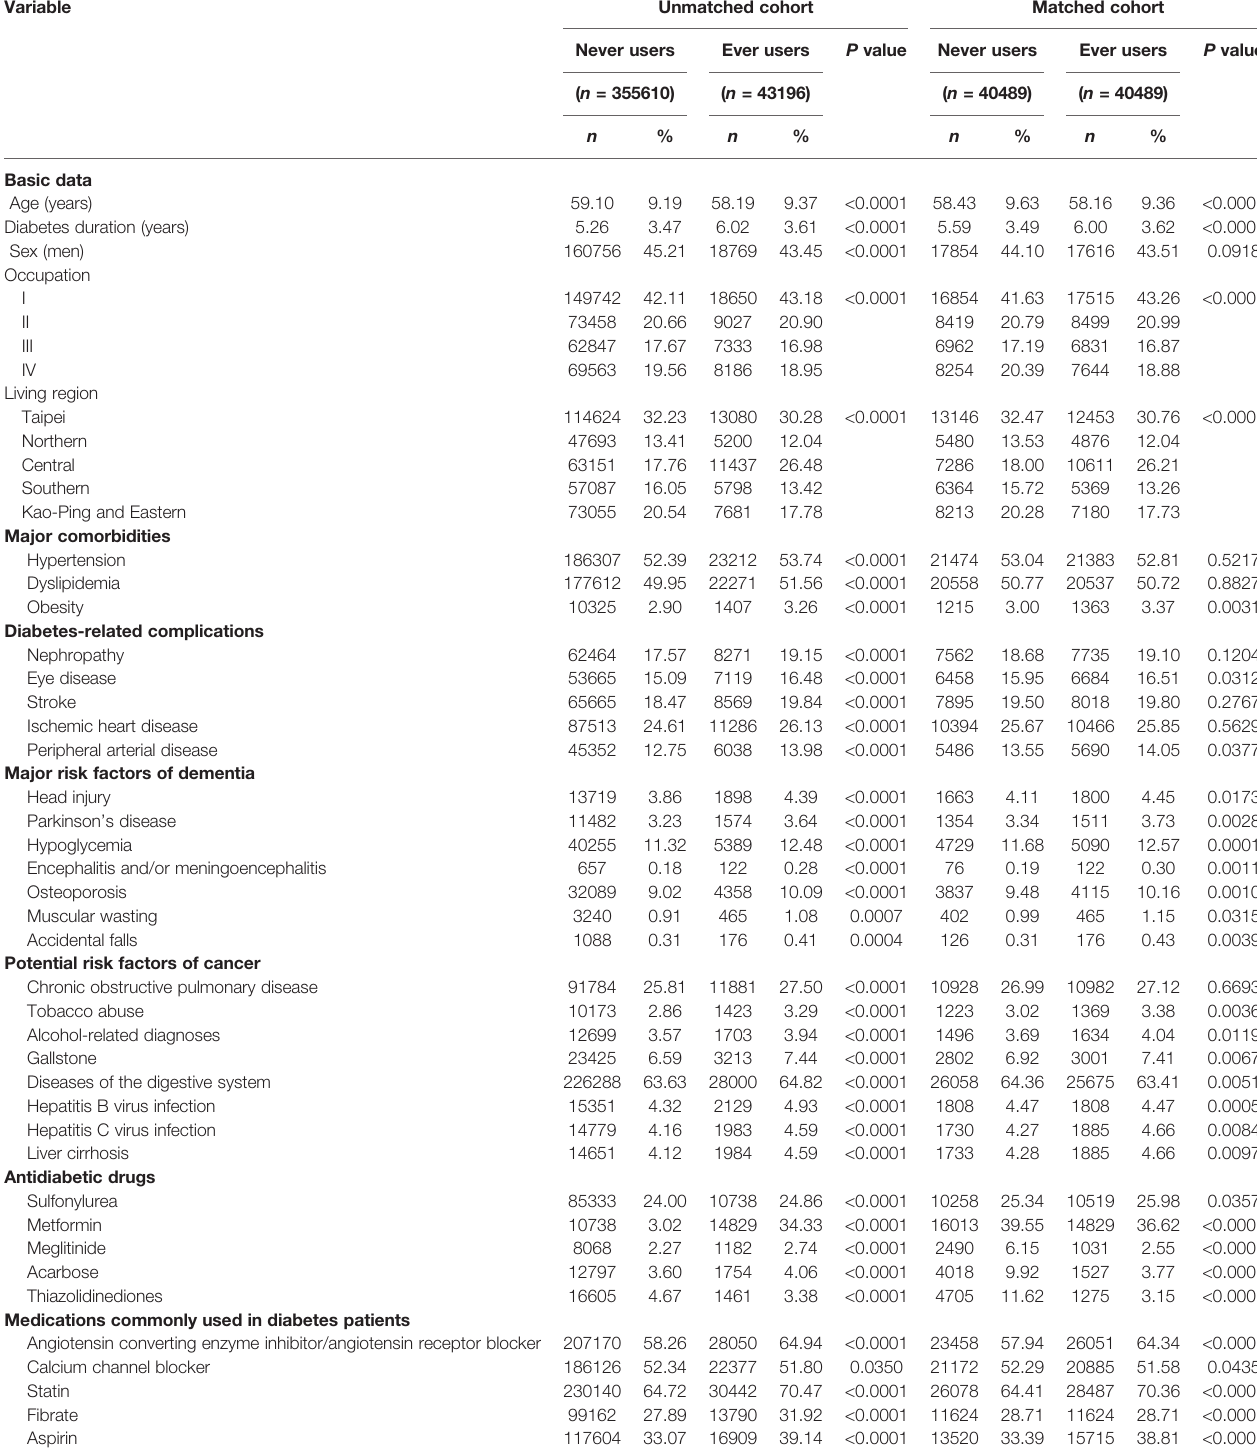
TABLE 1 | Characteristics of never users and ever users of vildagliptin in the unmatched original cohort and in the matched